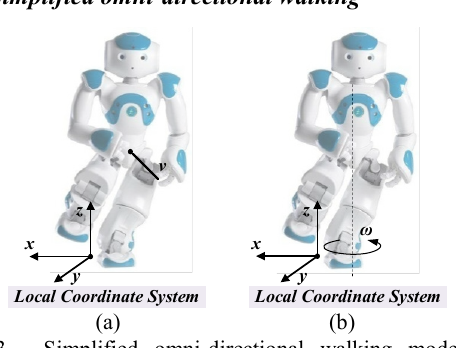
Fig. 3. Simplified omni-directional walking model. (a) Straight walking model. (b) Rotation model.